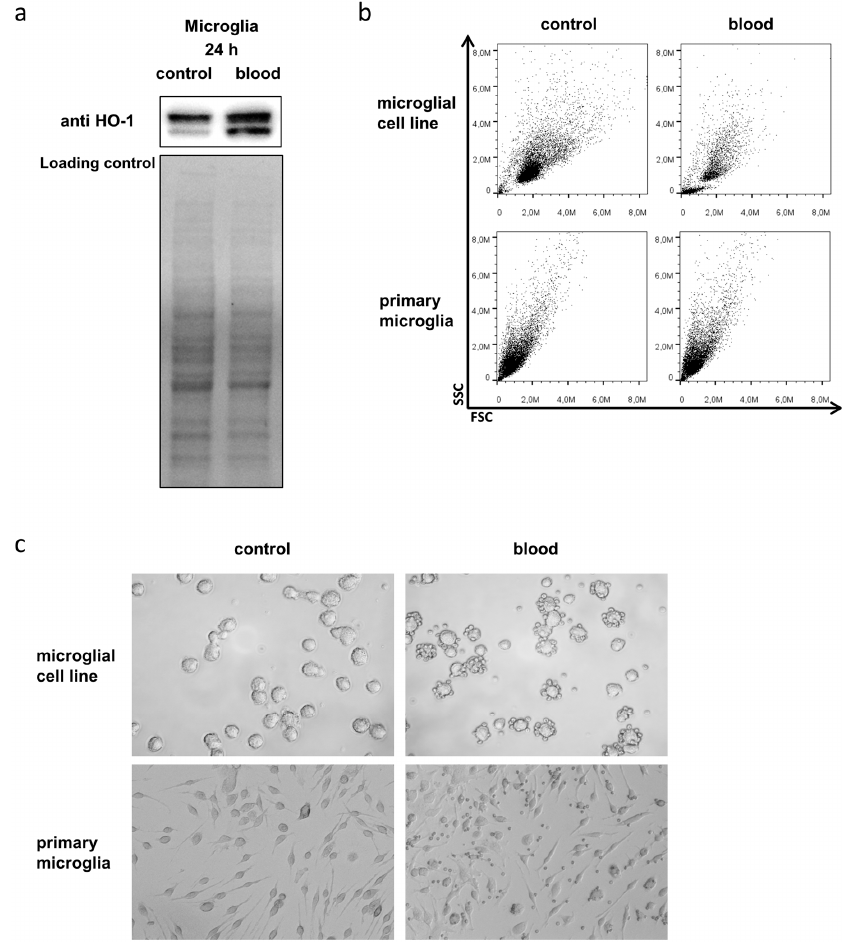
Figure 3. Microglial HO-1 expression and viability in response to blood exposure. ( a ) Representative Western blotting shows induction of HO-1 protein expression in BV-2 microglia in response to exposure to 10 µ L blood for 24 h. Double bands are due to antibody reactivity against the truncated form of HO-1. Lower panel shows corresponding loading control using total protein staining. ( b ) Representative flow cytometry FSC / SSC dot plots of BV-2 microglia (upper panel) and primary microglia (lower panel) without and with blood exposure (10 µ L accordingly). ( c ) Representative light microscopy images of BV-2 microglia and primary microglia before (left panel) and after blood exposure (right panel; 10 µ L accordingly; after washing step to remove erythrocytes). Unchanged morphology, size, and granularity of microglia after exposure to blood indicated unchanged